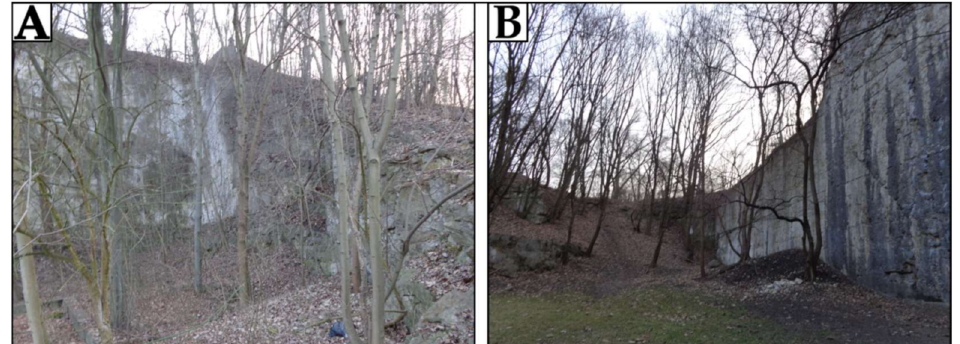
Figure 13. One of the roads leading to the Old Town (Poselska Str.), the height difference of which used to be 7 m between the Holocene alluvial plain and the Pleistocene terrace. At present it is 5 m. The road in front of the escarpment of high terrace has run along the intentionally created earth embankment (ramp) the slopes of which are beyond the visible walls. March 2021. Photo by R. Zarychta.